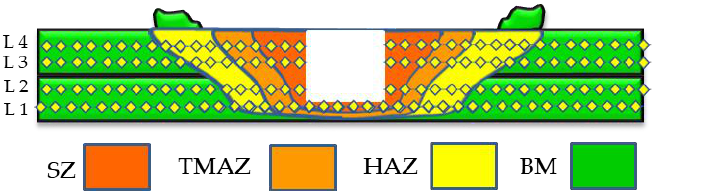
Figure 2. Schematic drawing for the measurement locations during the hardness test of the spot- welded joints.